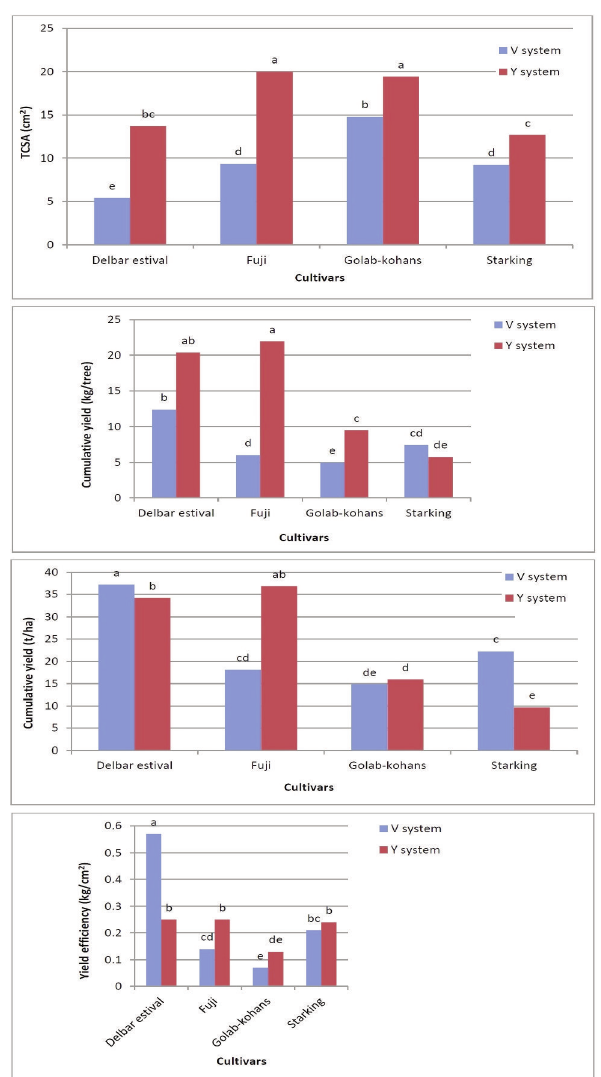
Fig. 1 Interaction of training systems (V-system and Y-system) and four cultivars (Delbar estival, Fuji, Golab-kohans, Starking) on fruit